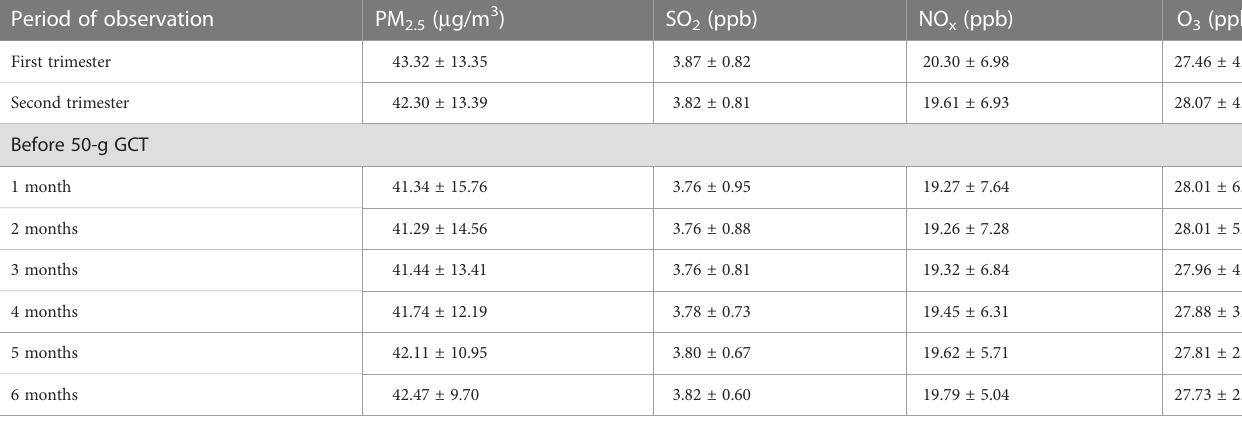
TABLE 2 Mean concentrations of air pollutants during a de fi ned period. Period of